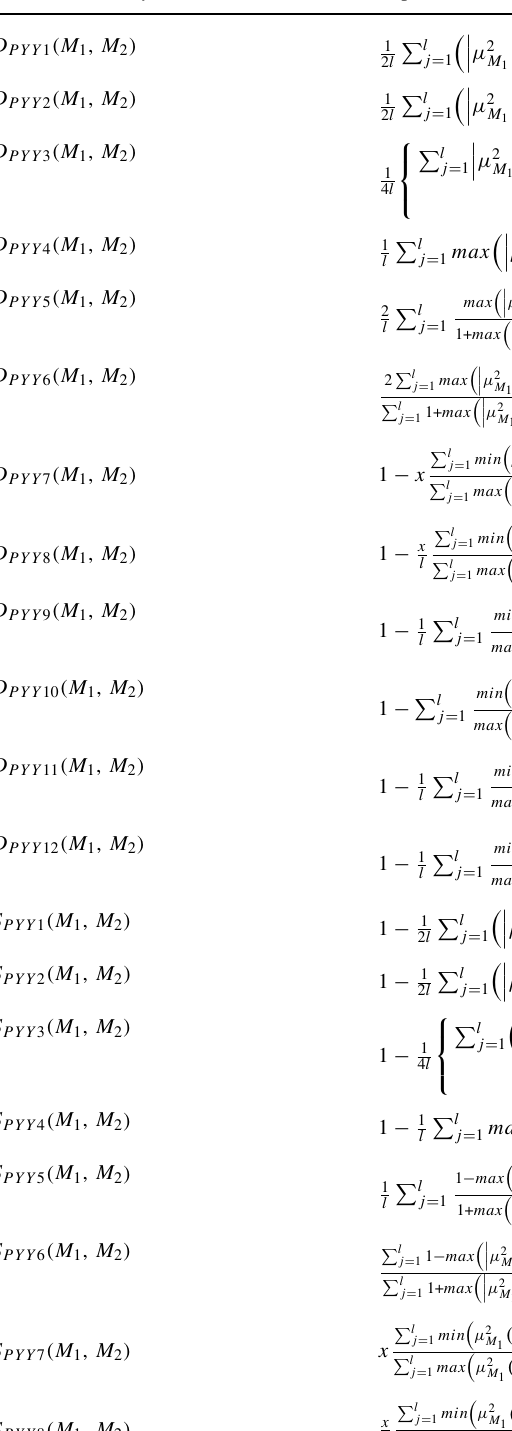
Table 4 Existing PF distance/similarity measures due to Peng et al. [14] Distance/similarity measure